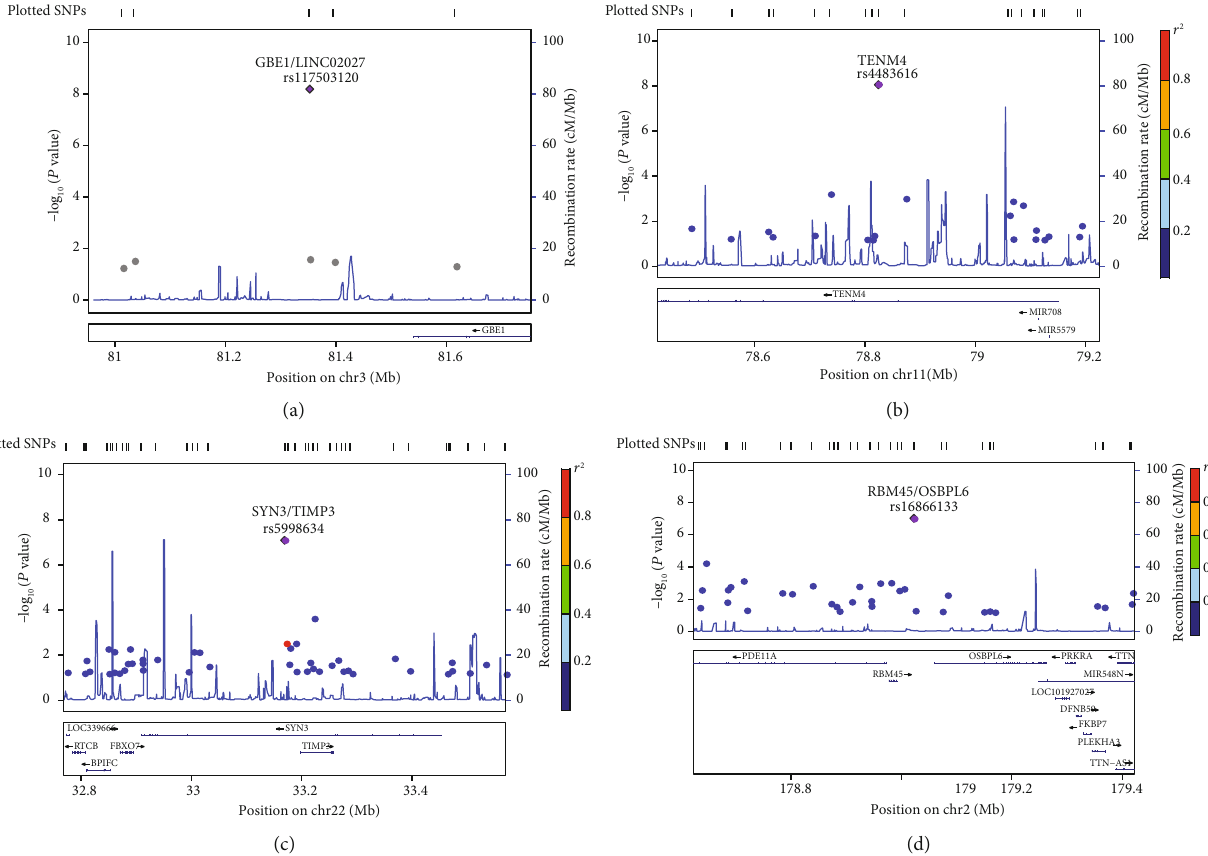
Figure 3: Regional plots of four signi fi cant loci. SNPs are plotted by position on chromosome against association with ITP (-log The SNP name shown on the plot was the most signi fi cant SNP. The association between GBE1/LINC02027 , TENM4 , SYN3/TIMP3 , RBM45/OSBPL6 , and ITP in Chinese Han Population showed that the most signi fi cant site was rs117503120, rs4483616, rs5998634, and rs16866133, respectively, which were supported by the LD site (a – d). Plots were generated using LocusZooM (http://csg.sph.umich.edu/